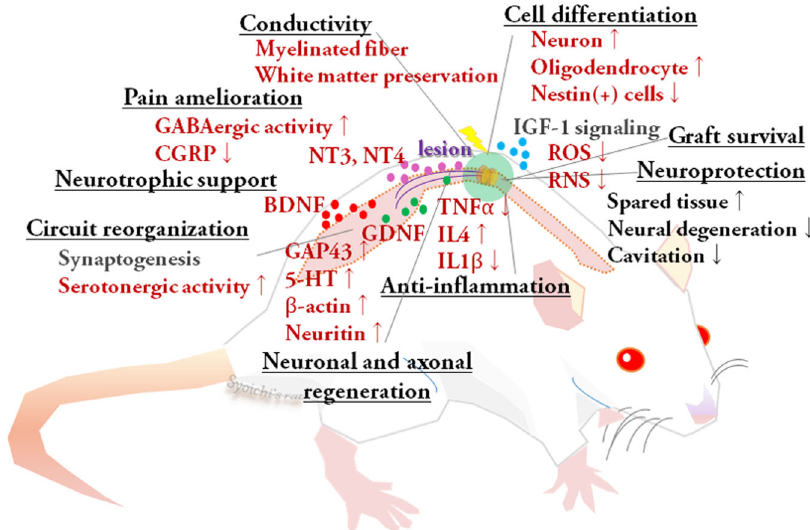
Fig. 1 Mechanisms of regenerative rehabilitation revealed in preclinical studies. The mechanisms of regenerative rehabilitation are brie fl y summarized in this scheme. Studies lacking comparisons of trained and untrained groups and studies including only a few animals were excluded. BDNF brain-derived neurotrophic factor, CGRP calcitonin gene-related peptide, GAP43 growth-associated protein 43, GDNF glial cell line-derived neurotrophic factor, IGF-1 insulin-like growth factor, IL1 β /4 interleukin 1 β /4, GABA gamma aminobutyric acid, NT-3/-4 neurotrophic factor 3/4, RNS reactive nitrogen species, ROS reactive oxygen species, TNF α tumor necrosis factor α , 5-HT